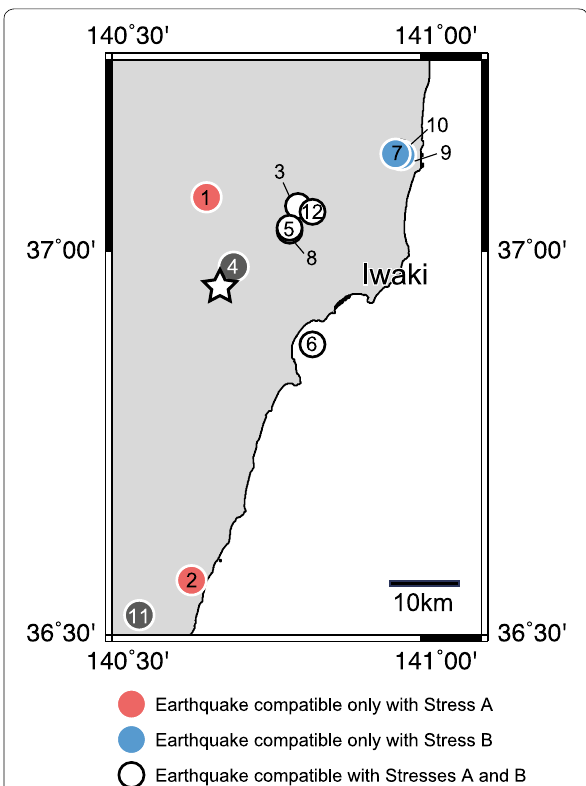
Fig. 4 Spatial variations in crustal stresses around Iwaki City prior to the 2011 Tohoku earthquake. Numbered circles are earthquakes used in this study. The star indicates the epicenter of the 2011 Iwaki earthquake. The two earthquakes (nos. 4 and 11) located deeper than 15 km are not discussed further in this study, as we focus on shallow crustal